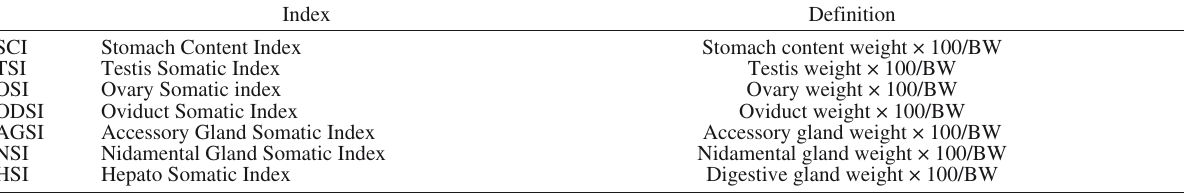
Table 1. – Definitions of somatic indices in Ommastrephes bartramii (BW=body weight in g) (Kidokoro and Sakurai 2008).